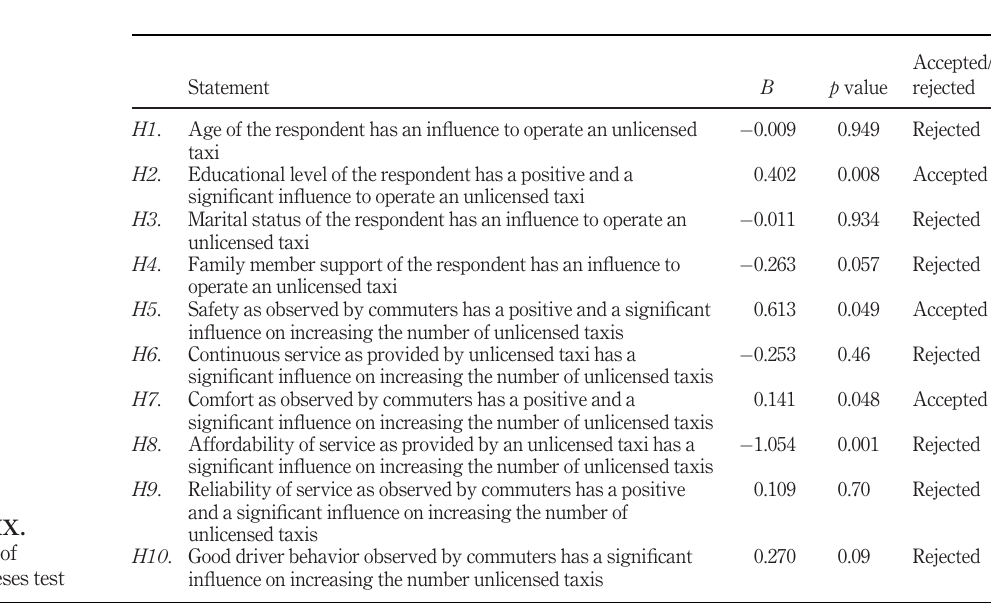
Table VIII. Result of regression analysis for the E-taxi driver ’ s socio- economic